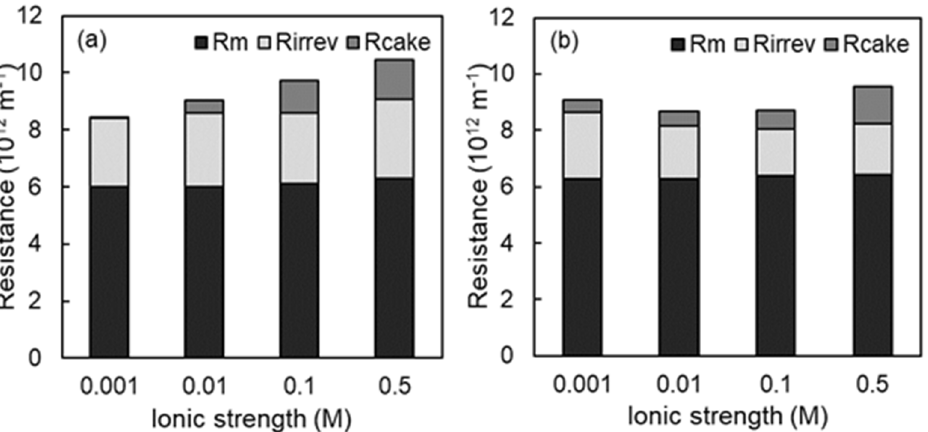
Figure 6. Dependence of membrane fouling resistances ( R irrev and R cake ) on ionic strength at pH of 7 for ( a ) BSA and ( b ) Lys filtration with PVP-grafted Carbosep M1 membrane. ( R m = membrane resistance; unmodified membrane irreversible BSA and Lys fouling resistances for the indicated ionic strength range are 4.7–5.3 × 10 12 m − 1 and 2.8–3.5 × 10 12 m − 1 , respectively).